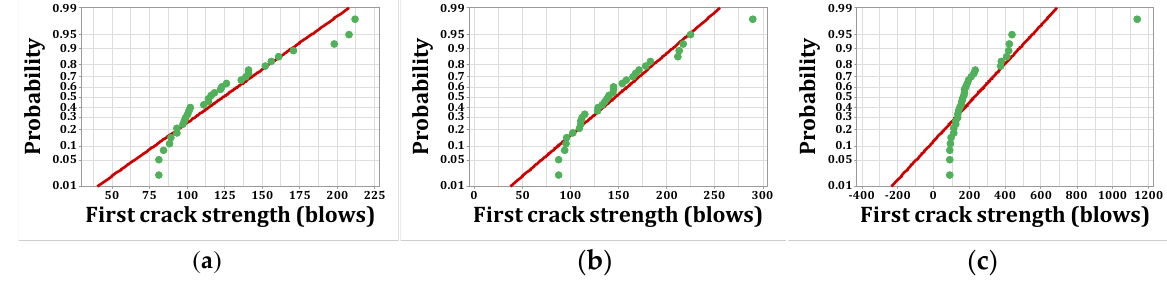
Figure 17. Normal probability plots for first crack (dry): ( a ) R, ( b ) F2, ( c ) F3.